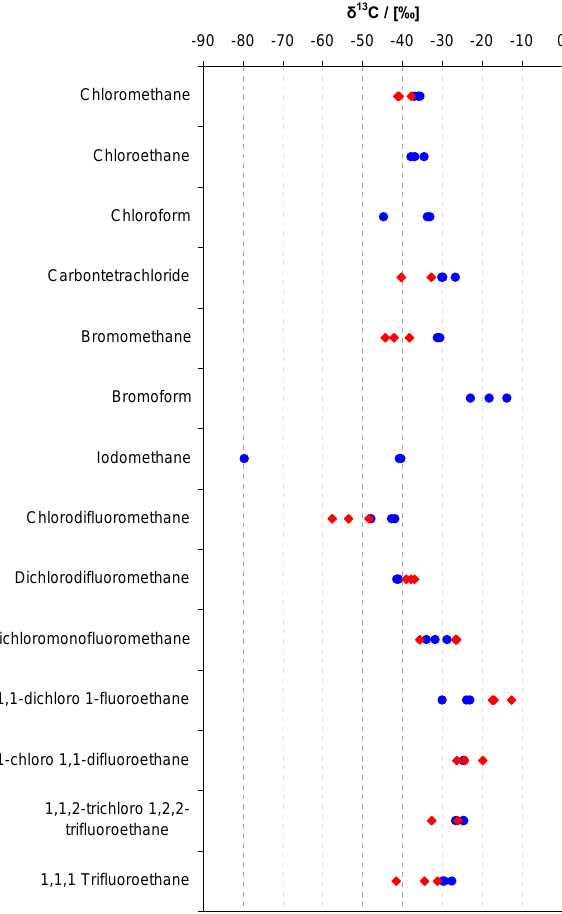
Fig. 4. Variability of the δ 13 C values of selected halocarbons in urban and coastal air samples. Urban air samples are marked with red diamonds and coastal samples are marked with blue dots.